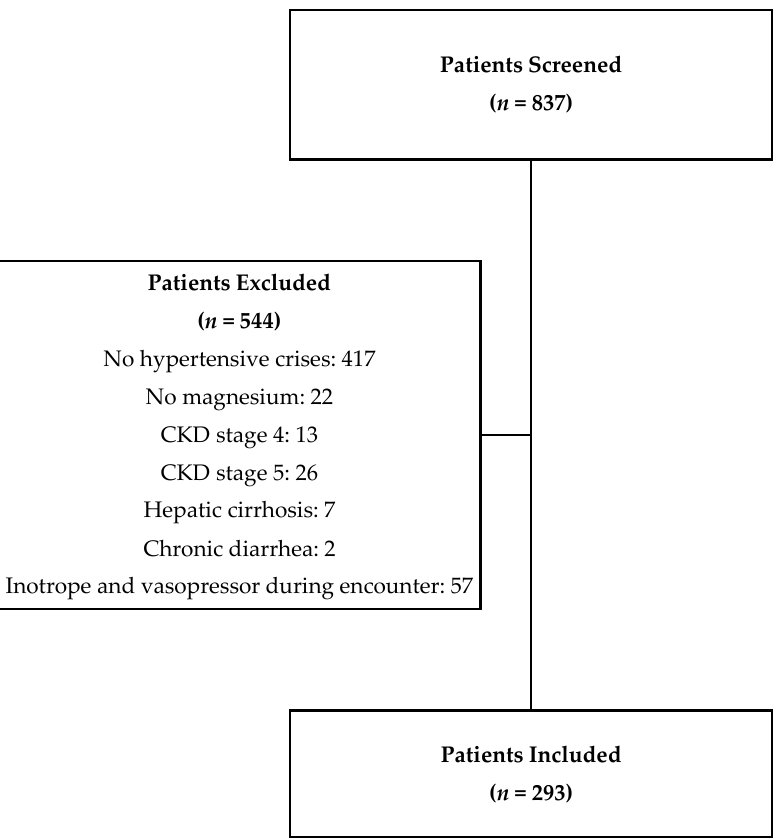
Figure 1. Flow chart of inclusion in study cohort. CKD — chronic kidney disease. Table 1. Baseline characteristics ( N = 293).